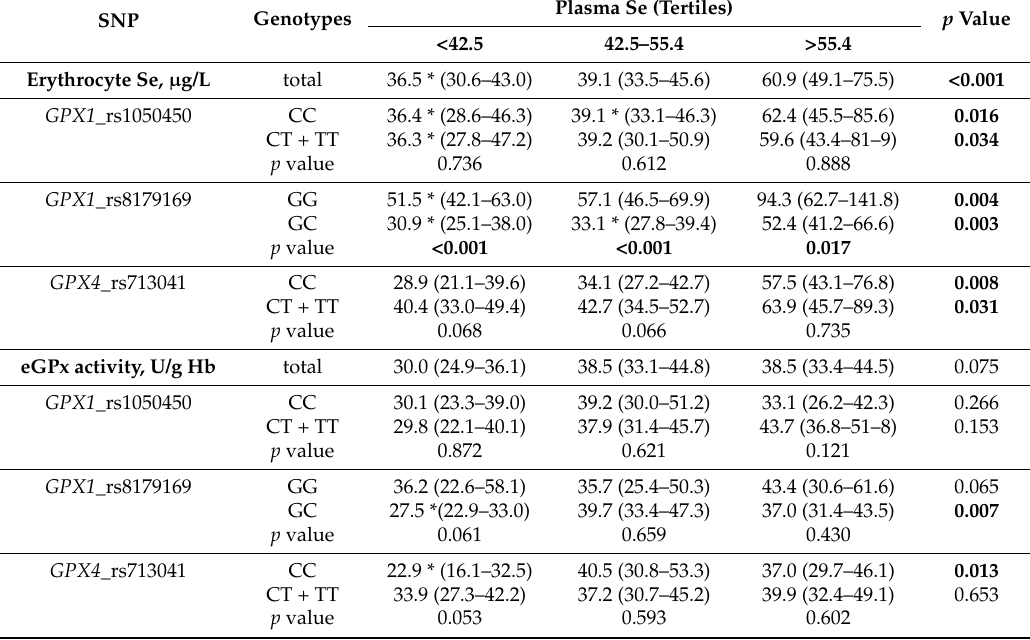
Figure S1). Lower erythrocyte Se concentrations were observed in individuals with GC genotype compared to individuals with CC genotype. No differences were observed for eGPx activity. Table 4. Gene effects on biomarkers of Se status according to tertiles of plasma